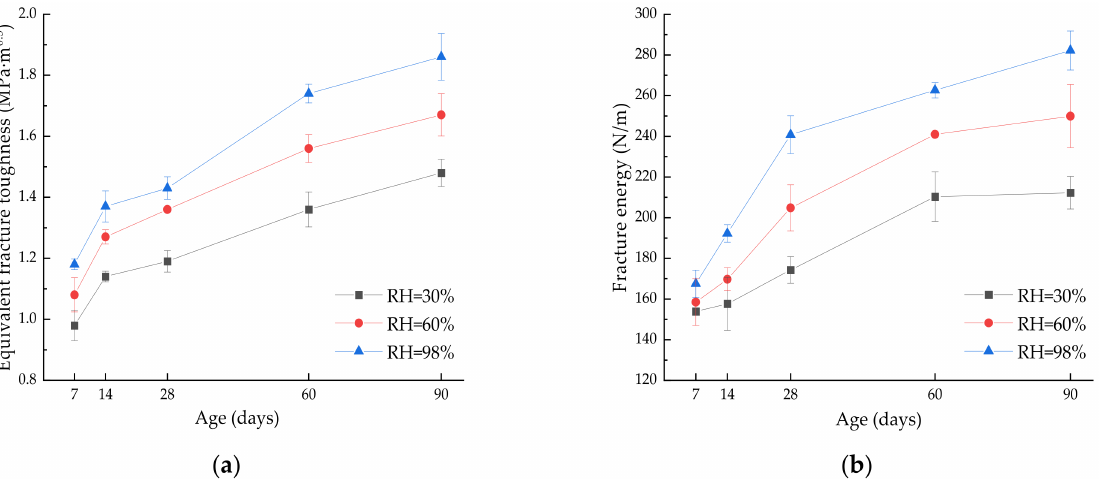
Figure 12. Fracture parameters of gallery concrete under different curing humidity: ( a ) equivalent fracture toughness; ( b ) fracture